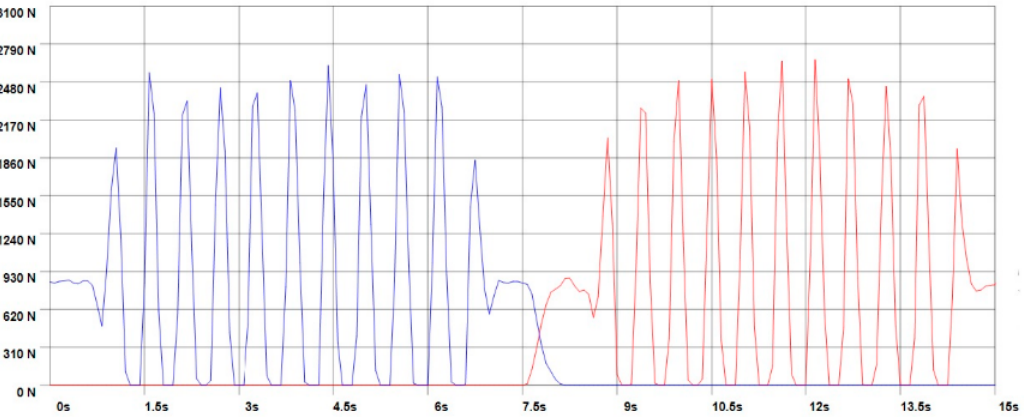
Figure 5. An example of 10 consecutive single-leg vertical hops vGRF values obtained in the right ( blue line ) and left ( red line ) legs consecutively, with the highest vGRF values representing the peak landing values. The first landing was registered at 1.6 s for the right limb and at 9.5 s for the left limb.